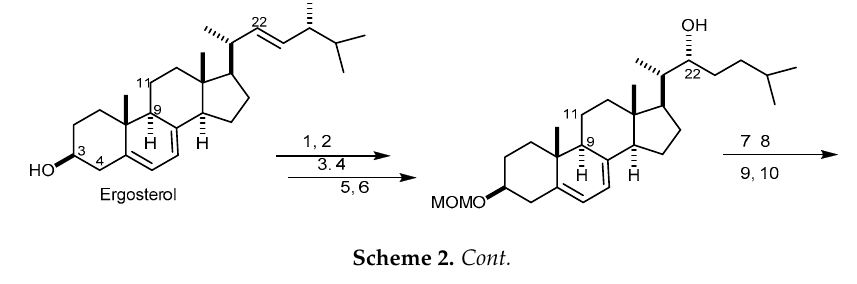
Scheme 2. Cont. Scheme 2.